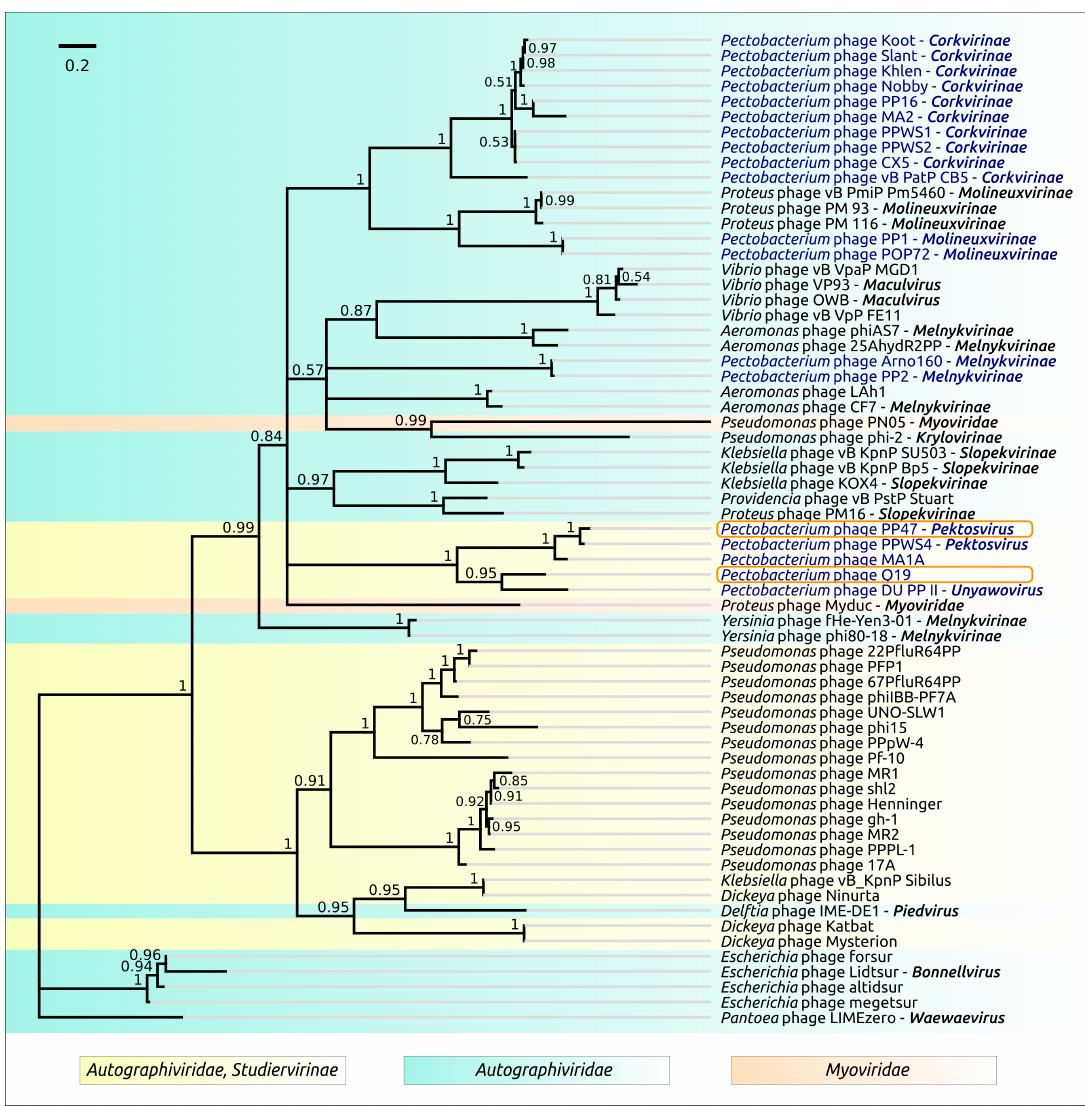
Figure 14. Phylogenetic tree obtained with MrBayes, based on amino acid sequences of tRNA-nucleotidyltransferase and homologous sequences obtained by a BLAST search of Genbank phage databases. Bayesian posterior probabilities are indicated above their branch. The scale bar shows 0.2 estimated substitutions per site and the tree was rooted to Pantoea phage LIMEzero; of 2,000,000 generations, every 200 generations were sampled, with an average standard deviation of split frequencies of 0.0071.